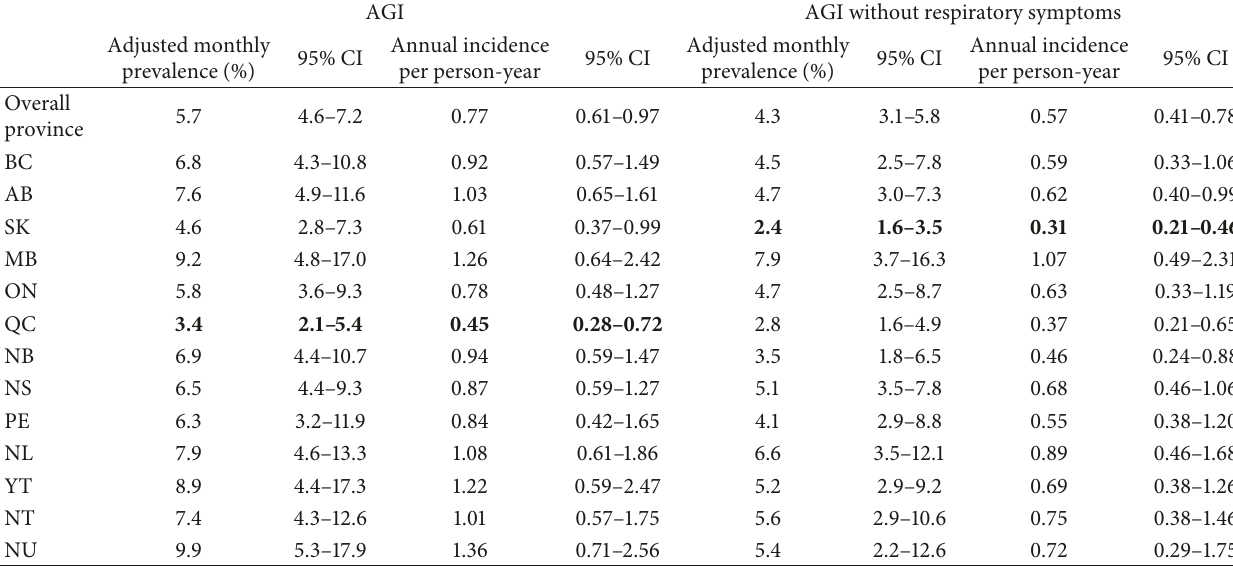
Table 2: Monthly prevalence (95% CI) and annual incidence rate (95% CI) of self-reported acute gastrointestinal illness (AGI) in Canada by province, 2014-2015.